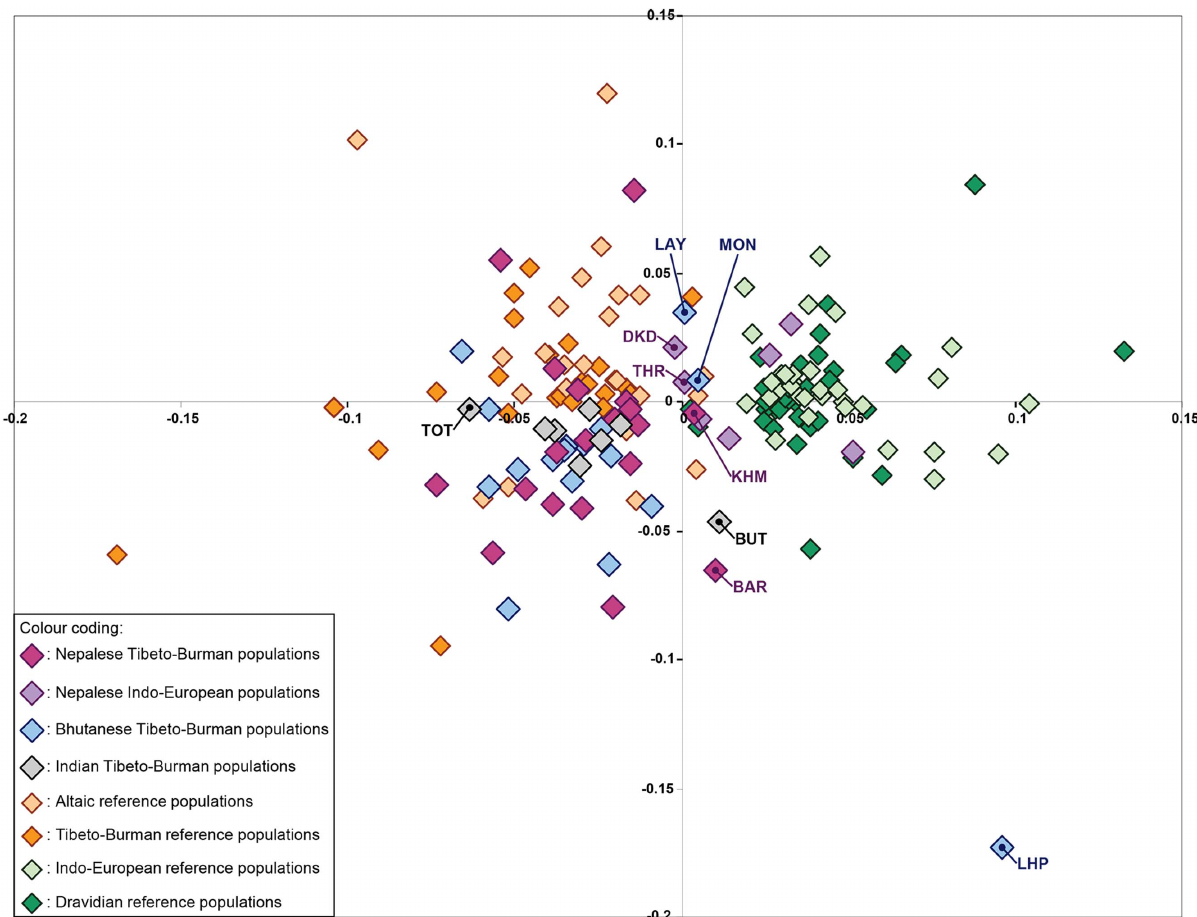
Figure 4. MDS plot. Populations have been colour coded according to linguistic phylum and geographical origin, as is explained within the figure. The population-codes used in this plot are explained in table 1 and table S1. The stress values for the dimensions used to construct this plot were 0.333475 and 0.216317 respectively.